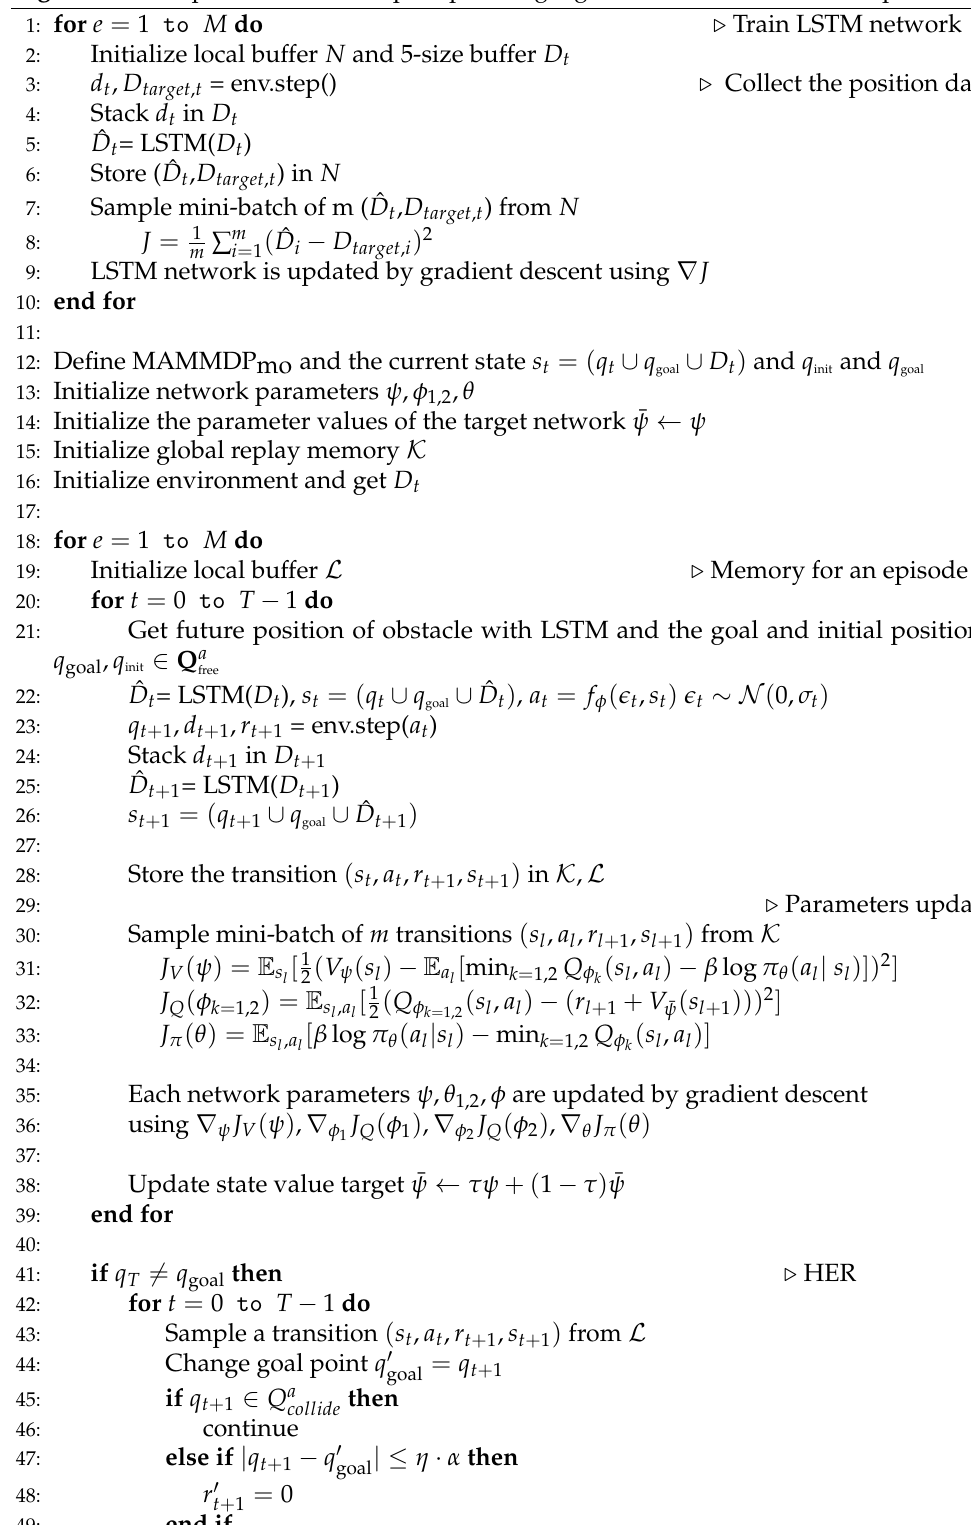
Algorithm 1 Proposed SAC-based path planning algorithm for multi-arm